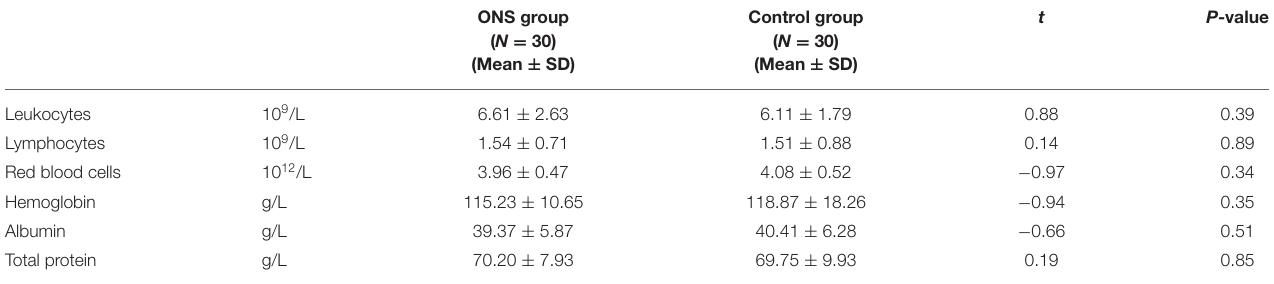
TABLE 2 | Baseline characteristics of the biochemical indicators of the study